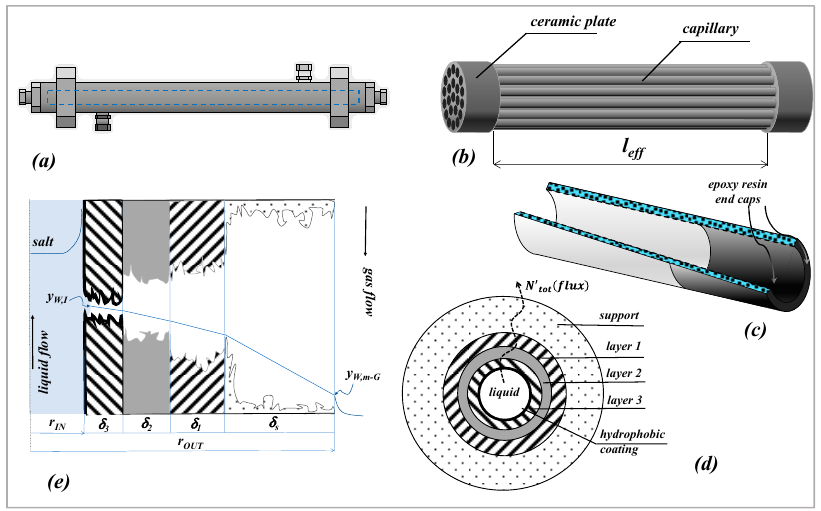
Figure 1. Scheme of membrane and module. ( a ) housing; ( b ) capillary bundle; ( c ) section of a cylindrical membrane; ( d ) multilayer membrane cross section; ( e ) detail of the radial section of the coated membrane showing the water composition profiles, with reference to SGMD of a salt-water solution.